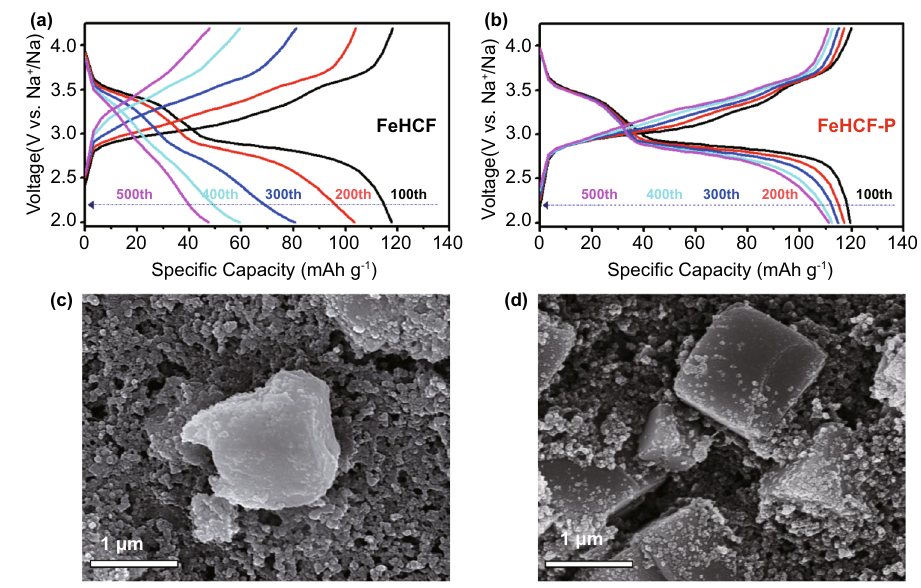
Fig. 3 Charge–discharge curves of a FeHCF and b FeHCF-P at different cycles. SEM images of c FeHCF and d FeHCF-P electrodes after 300